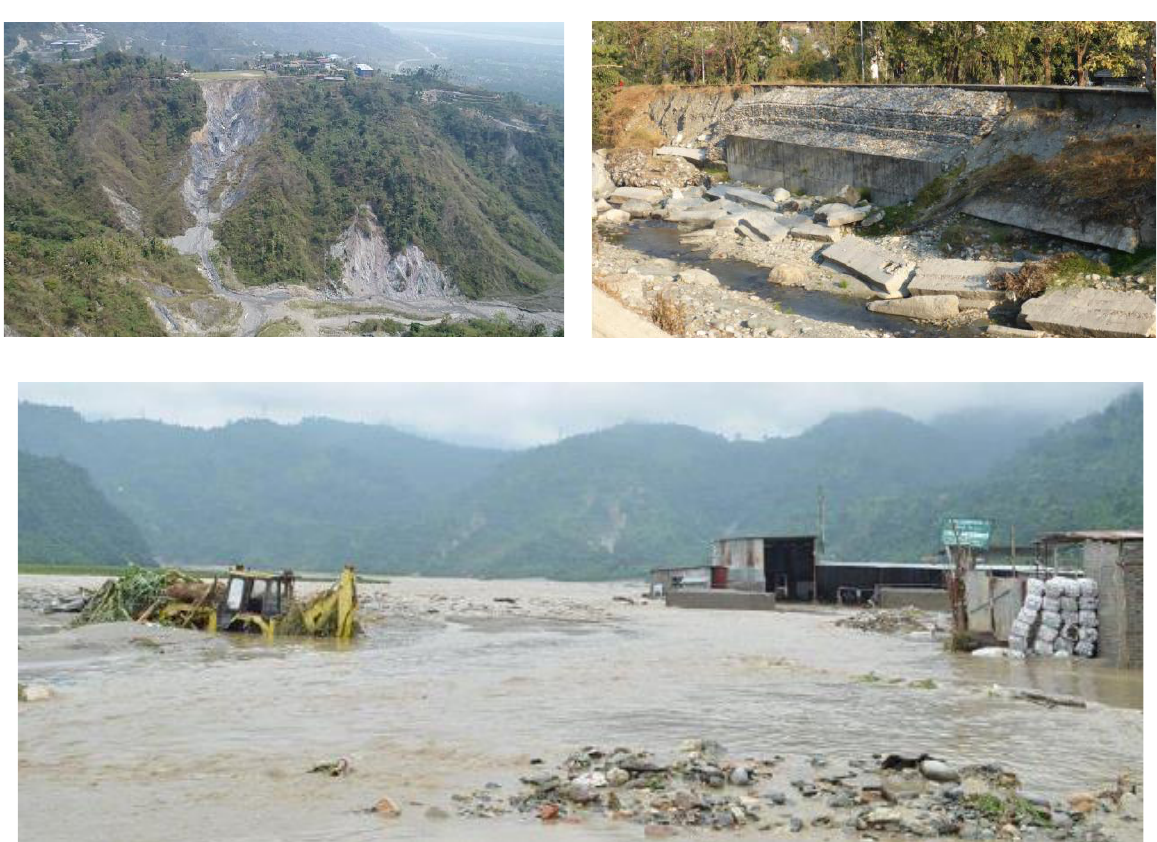
Figure 5. Disasters in Phuentsholing [48,49]. ( top left —Landslide damage, top right —flood damage; bottom —Devastating floods in the city).